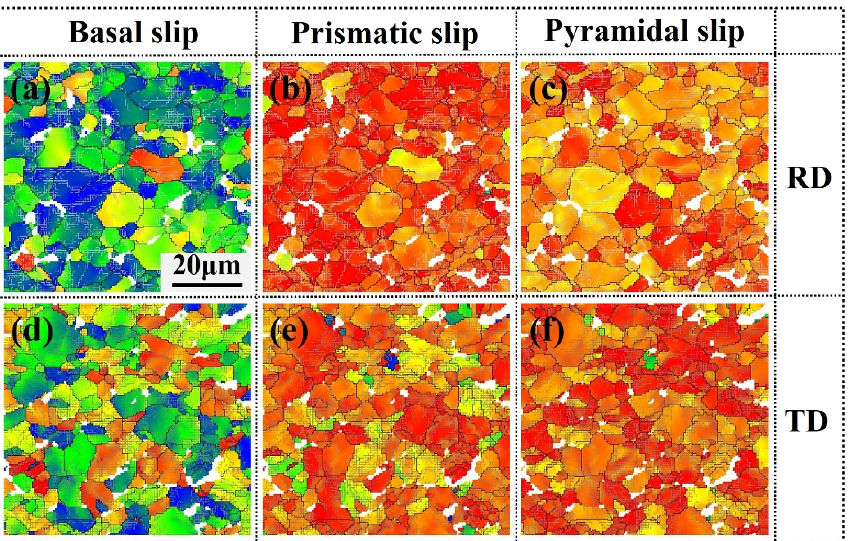
Figure 10. SF distribution maps for basal < a > slip, prismatic < a > slip, and pyramidal slip system in the tensile Zircaloy-4 ( a – c ) along the RD, and ( d – f ) along the TD.